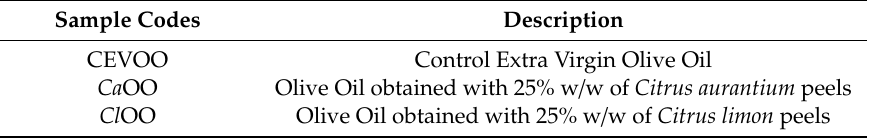
Table 2. Sample codes used to identify the olive oil formulations